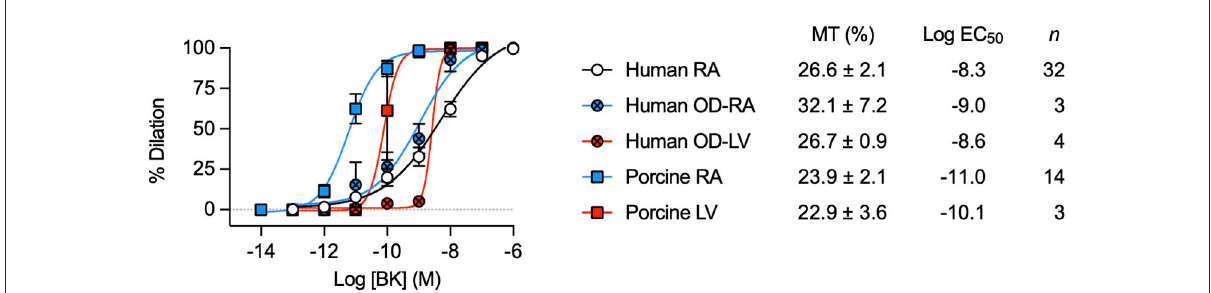
FIGURE1 Characterization of dilation to bradykinin in IMCAs mounted in a pressure myograph. Comparison of control concentration-dependent BK vasodilation responses across species and heart chambers. Data from human and porcine RA-IMCAs are compared to organ donor (OD) RA and left ventricle (LV) arteries, and porcine LV arteries. Values specific to the experiments performed in this study for both MT and the non-organ donor RA-IMCA concentration response curves to BK are modified from Dora et al. (18).